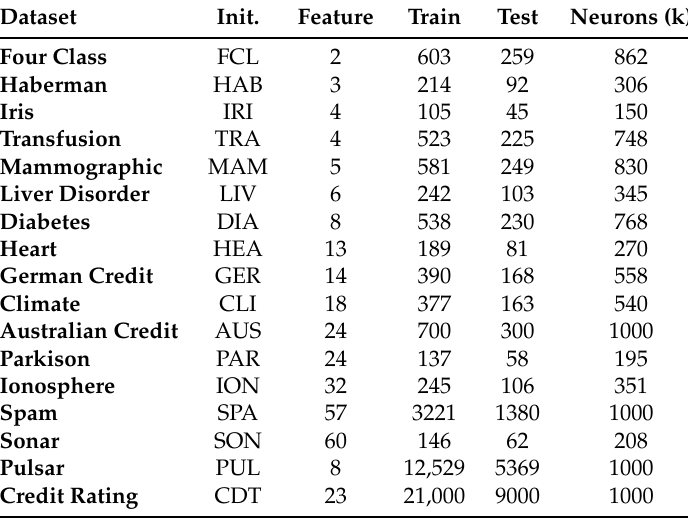
Table 4. Data sets used in the Classification experiments.